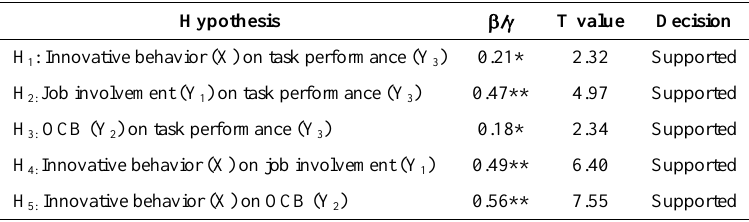
Figure 2. Standardized structural model Table 3. Result of hypothesis